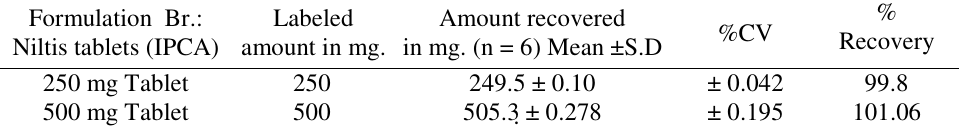
Table 2. Amount of nabumetone in tablet dosage forms by the HPLC method.